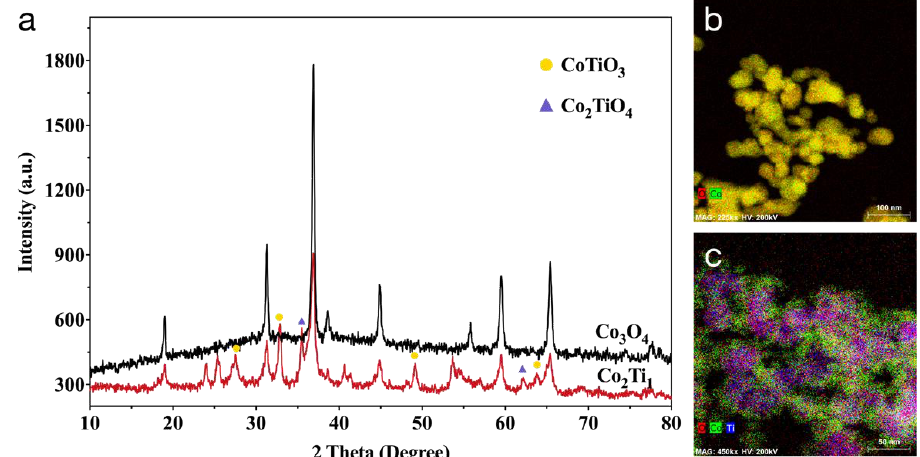
Figure 2. ( a ) XRD patterns and EDS elemental mapping images of ( b ) Co 3 O 4 and ( c ) Co 2 Ti 1 .